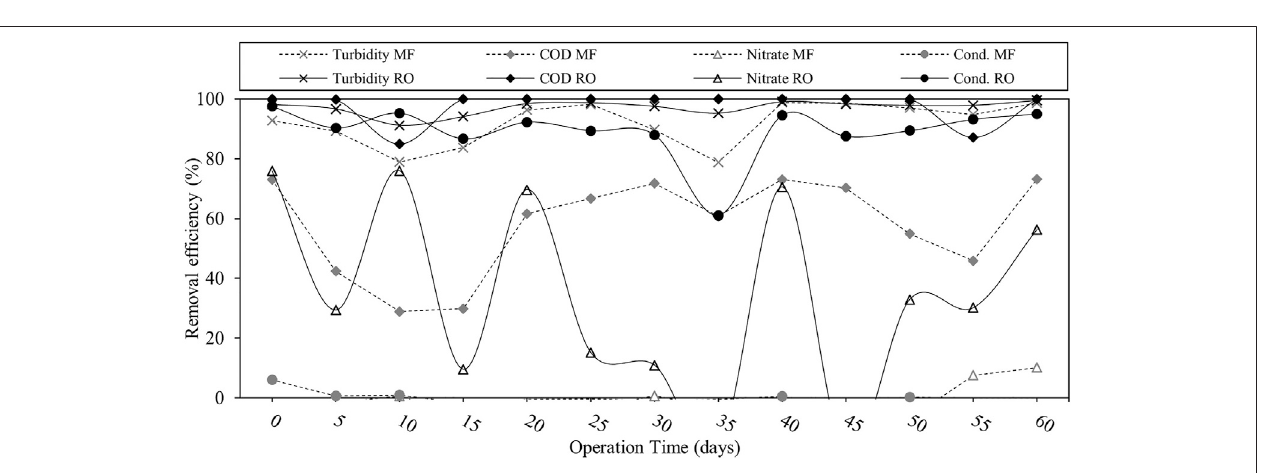
Frontiers in Chemical Engineering |